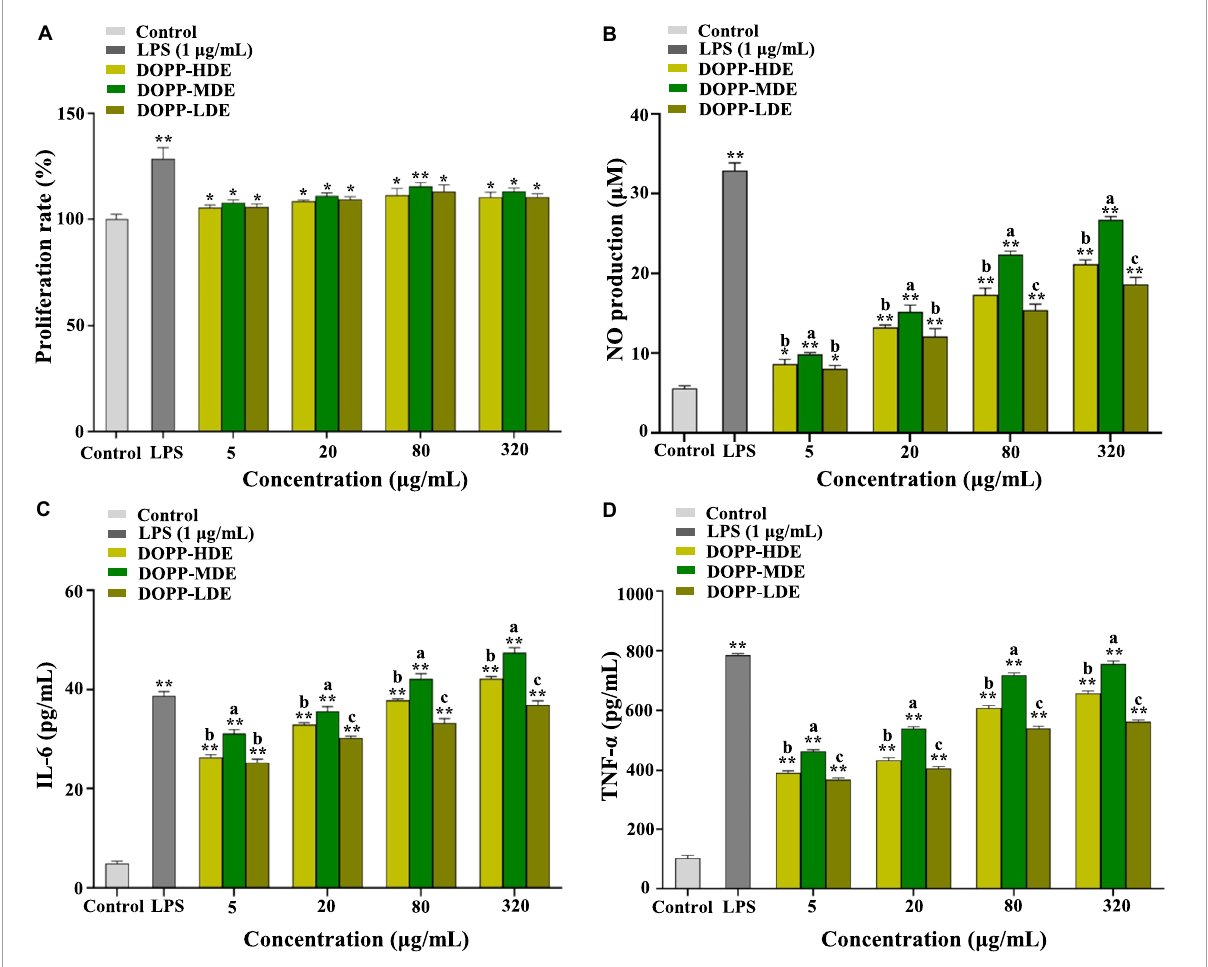
FIGURE5 Effects of okra pectic-polysaccharides (OPP) with various degrees of esterification on proliferation (A) , nitric oxide (NO) production (B) , interleukin-6 (IL-6) production (C) , and tumor necrosis factor- α (TNF- α ) production (D) of RAW 264.7 macrophages. The sample codes were the same in Figure 1 ; the error bars are standard deviations; significant differences of cell proliferation and release of NO, IL-6, and TNF- α in LPS, DOPP-HDE, DOPP-MDE, and DOPP-LDE vs. control are shown by * p < 0.05, ** p < 0.01. Significant differences ( p < 0.05) of release of NO, IL-6, and TNF- α among DOPP-HDE, DOPP-MDE, and DOPP-LDE are shown by data bearing different letters